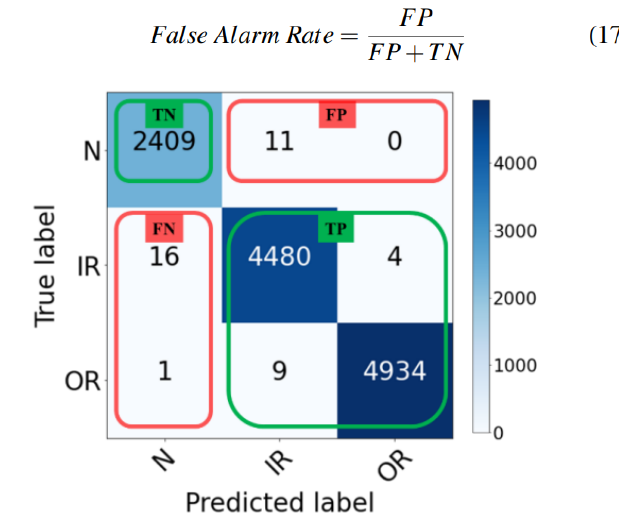
Fig. 10. Confusion matrix of the model